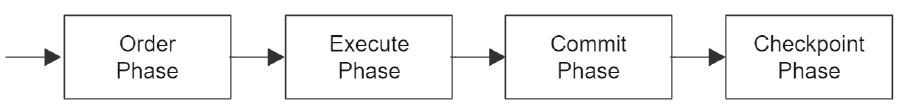
Figure 2. Order-then-execute transaction processing model.